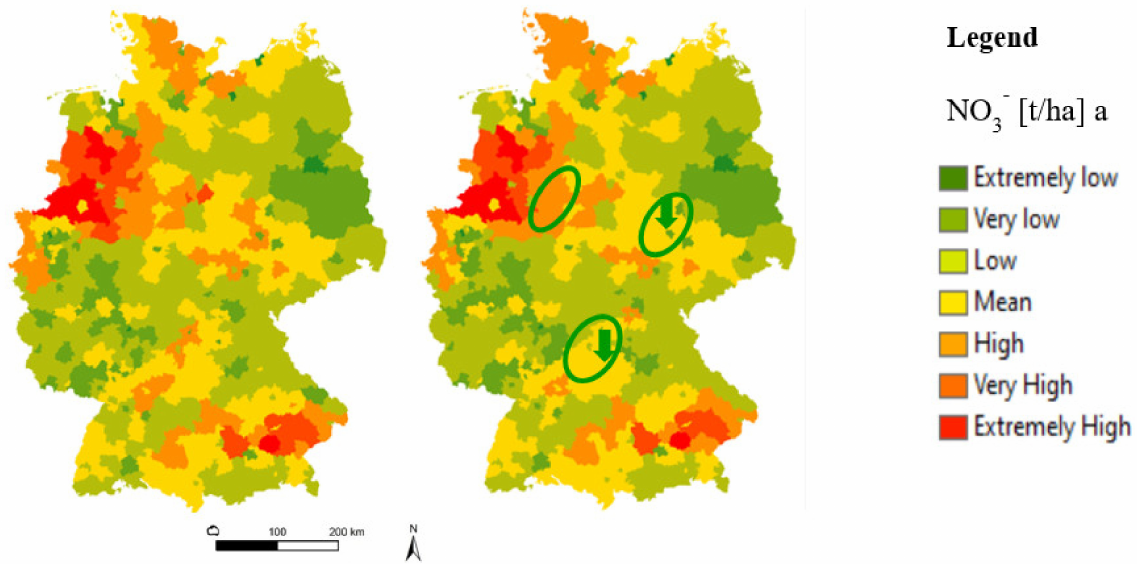
Figure 6. NDR (nutrient deliver ratio) (NO 3 − [t/ha] a) result for current state 2018—left ( high ) and future 2050—right ( low ) scenario on nitrates concentration in tons per hectare at municipality level as simulated by our model. The green arrows in the map show how nutrient delivery will decrease in the year 2050. The northwest will experience lower nitrate loads as well as the south in 2050 compared to the current situation, and the same is applicable in the eastern part of the country. This is explainable as the RGPs powered with maize will automatically switch off (when it is no more cost effective and environmentally safe), while the ones powered with water and electricity will strive more starting from the year 2045 upwards when they are more technologically ready and